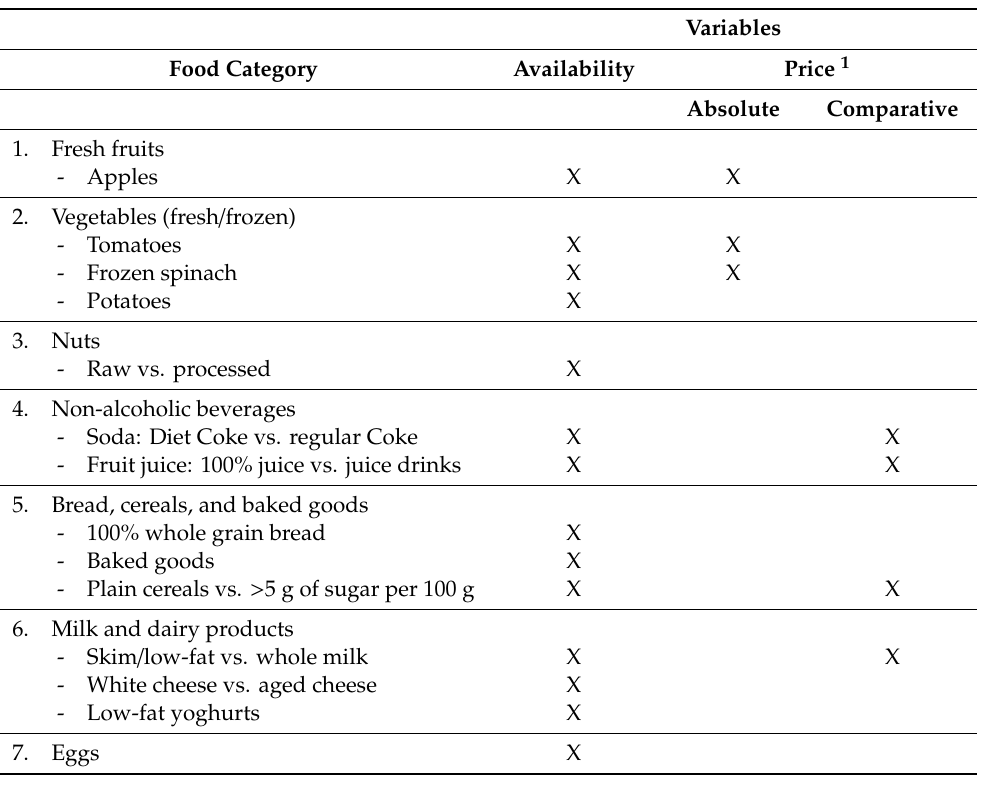
Table 1. Food categories and food items included in the adapted Nutrition Environment Measures Survey in stores for Mediterranean contexts (NEMS-S-MED) audit